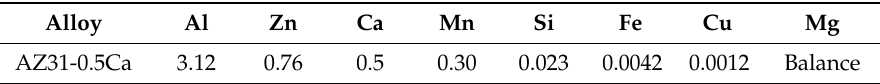
Table 1. The composition in wt.% of AZ31-0.5Ca